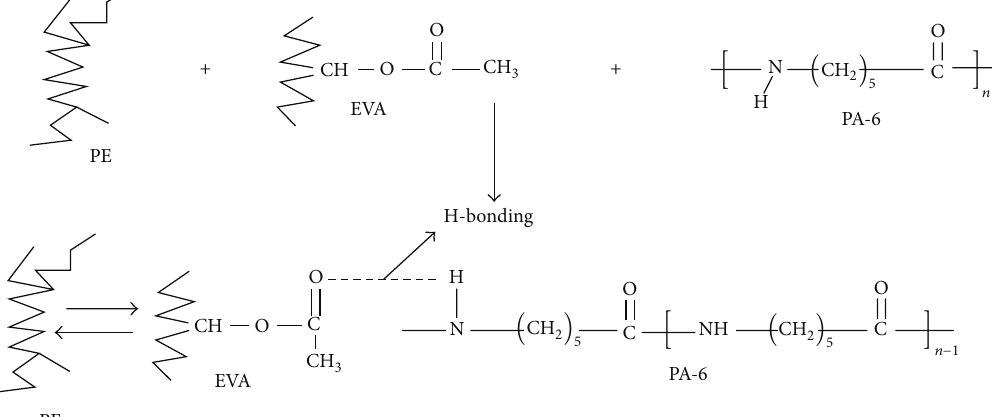
Scheme 1: Possible chemical reactions between PE, PA-6, and